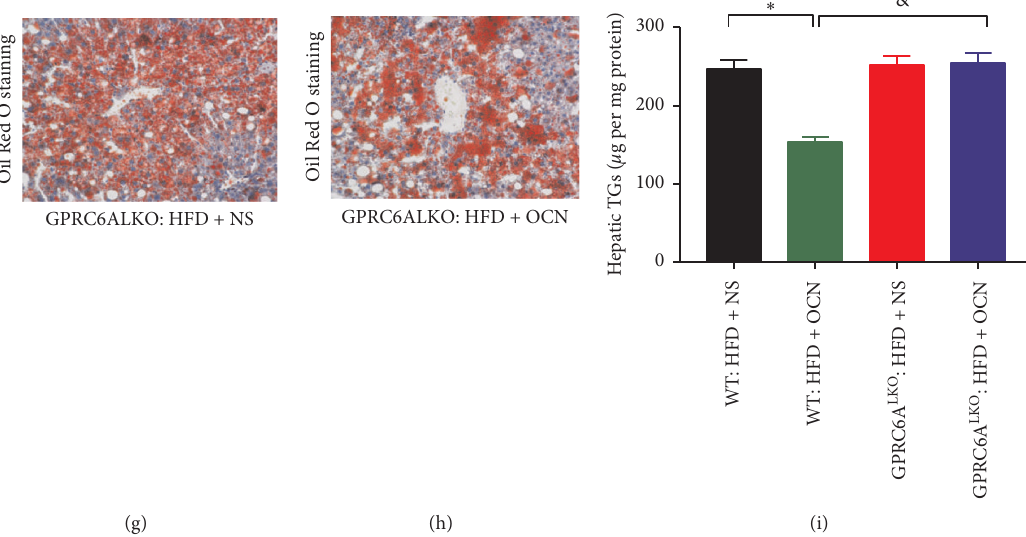
Figure 3: The effects of osteocalcin and GPRC6ALKO on HFD-induced hepatic steatosis. H&E staining ( × 400) and Oil Red O staining ( × 200) were performed in the liver tissues: (a), (e) WT:HFD +NS; (b), (f) WT :HFD+OCN; (c), (g) GPRC6ALKO :HFD +NS; (d), (h) GPRC6ALKO :HFD+ OCN; (i) liver content of TGs. In Figure 3(i), data were expressed as the mean ± SEM and were analyzed by in- dependent-samples T -test. ∗ P < 0 . 05, the WT :HFD +OCN group compared with the WT :HFD+NS group. & P < 0 . 05, the GPRC6ALKO: HFD +OCN group compared with the WT :HFD +OCN group. GPRC6ALKO, liver-specific conditional GPRC6A knockout; WT, wild- type; NS, saline solution; HFD, high-fat diet; OCN,